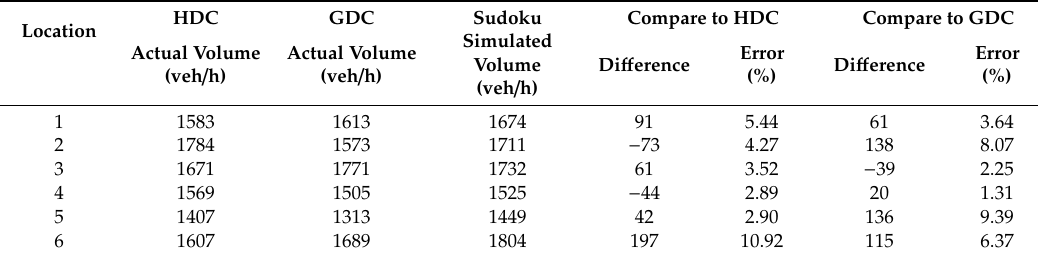
Table 1. Comparison of actual and simulated tra ffi c volumes.